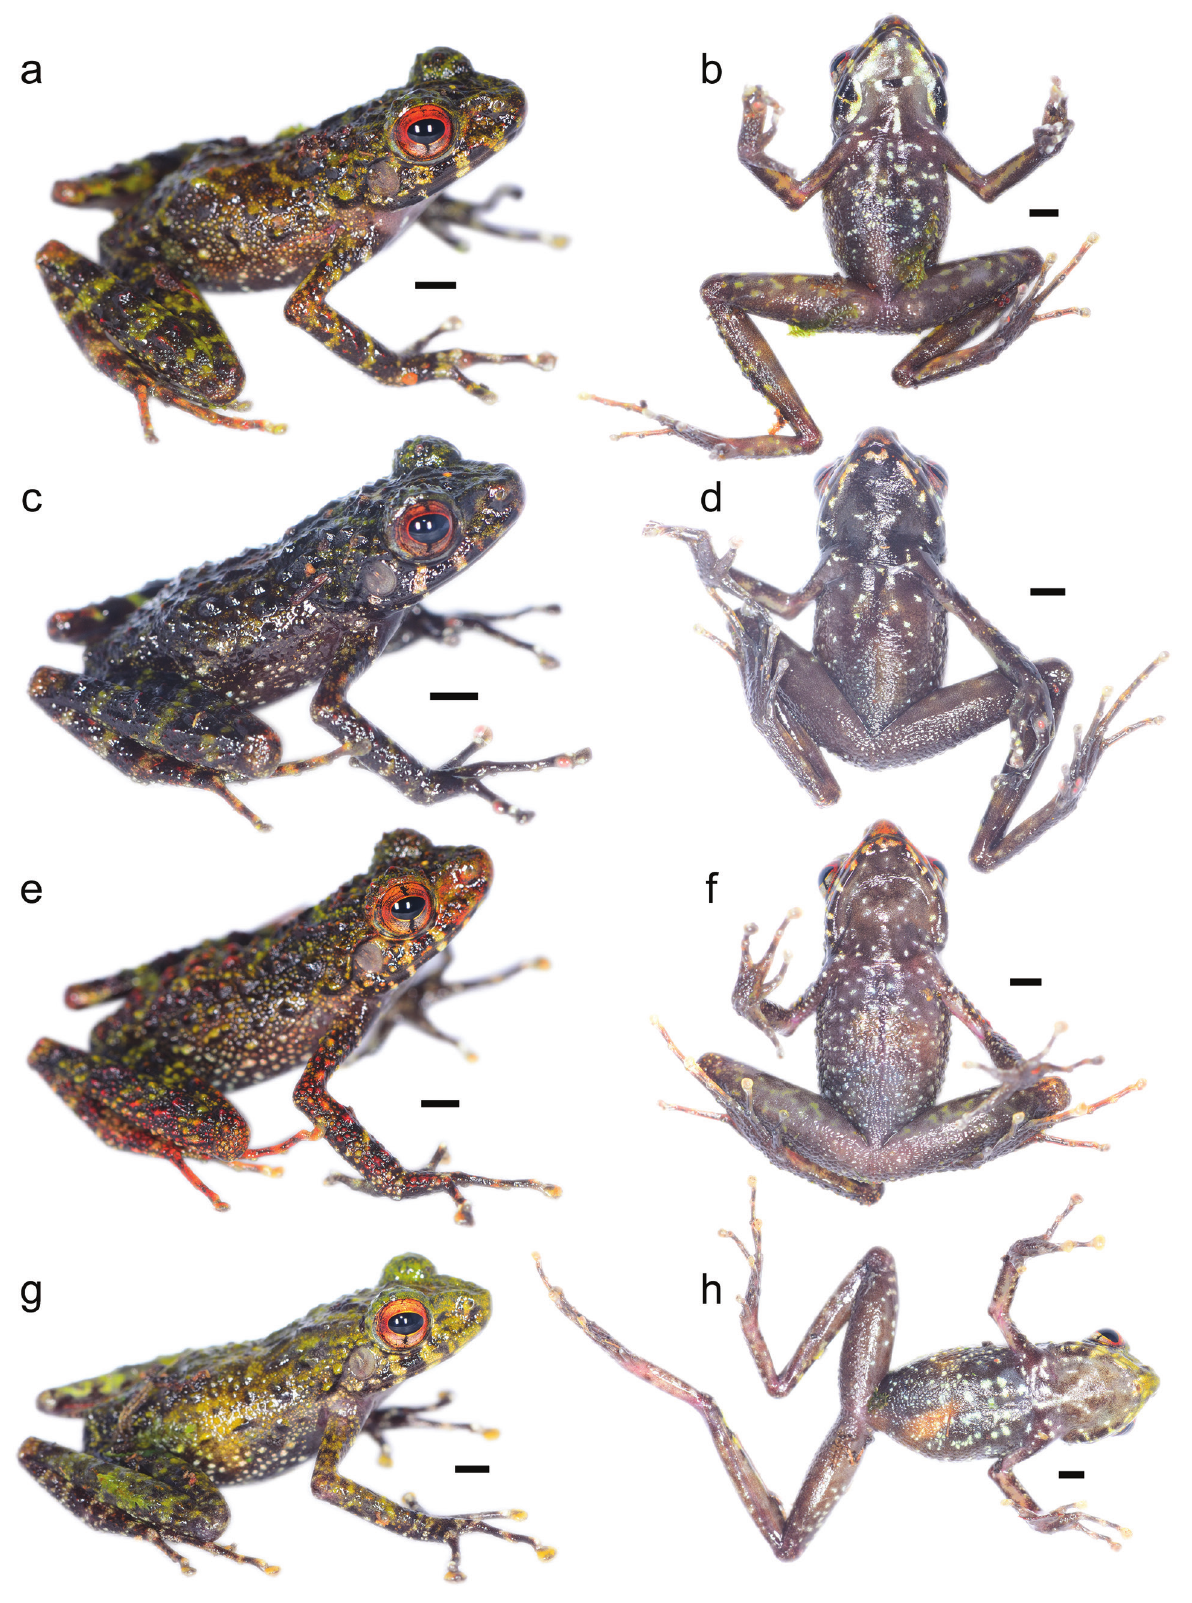
Figure 3. Morphological and chromatic variation among paratypes of Gephyromantis ( Vatomantis ) lomorina sp. n. from Marojejy in life. (a–b) ZSM 420/2016; (c–d) UADBA-A 60296; (e–f) UADBA-A 60295; and (g–h) ZSM 418/2016. Scale bars indicate 2 mm. gion concave, vertical. Tympanum distinct, fairly small, limbs and hindlimbs slender. Inner and outer metacarpal 53% of eye diameter. Supraocular spines absent. Weakly tubercle present, both indistinct. Finger discs enlarged, distinct supratympanic fold running from the eye over round. Subarticular tubercles distinct, dark in colour. No the tympanum to above the insertion of the arm. Fore- webbing between fingers. Comparative finger